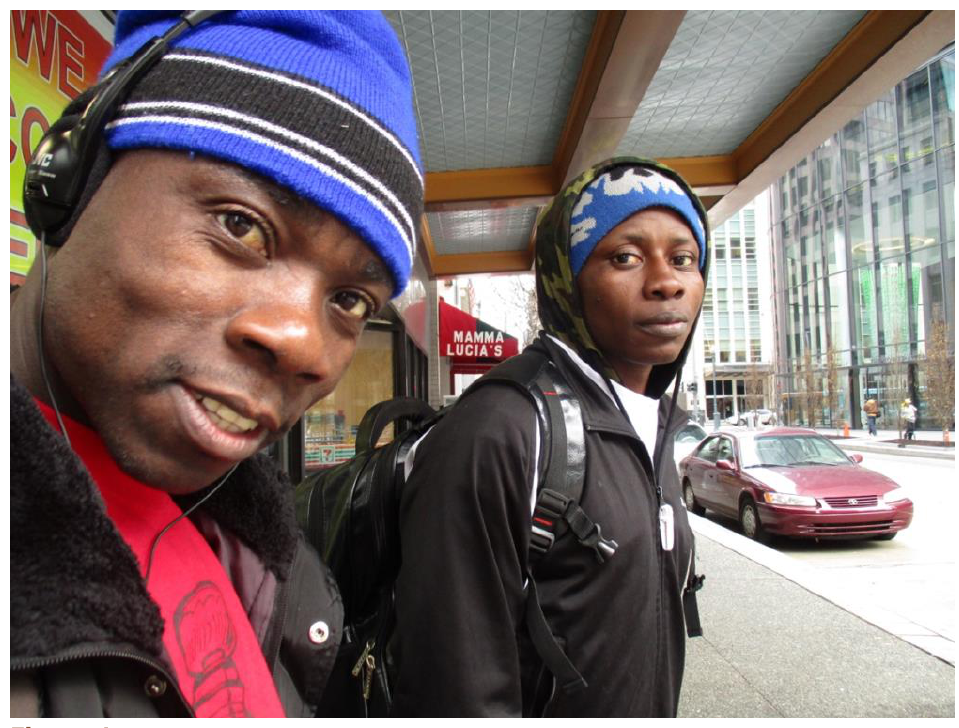
Omar Millán, With Work Colleagues at the Bus Station , Digital photograph, Pittsburgh, PA, December 5, 2016. Courtesy of Héctor Camilo Ruiz